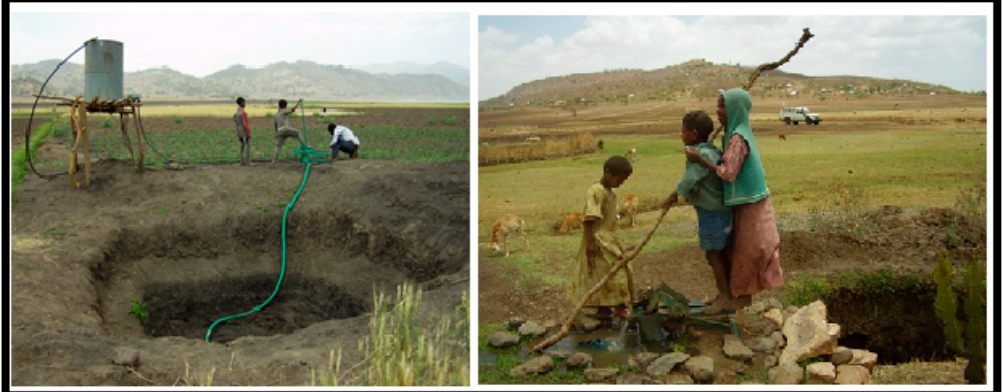
Figure 6. Groundwater abstraction using the treadle pump.